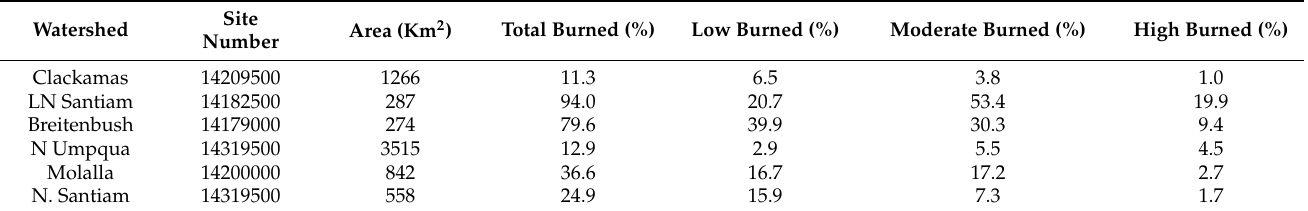
Table 2. Characteristics of six burned watersheds in Oregon with the total percentage burned and percentage of each burn severity class (low, moderate, and high burned